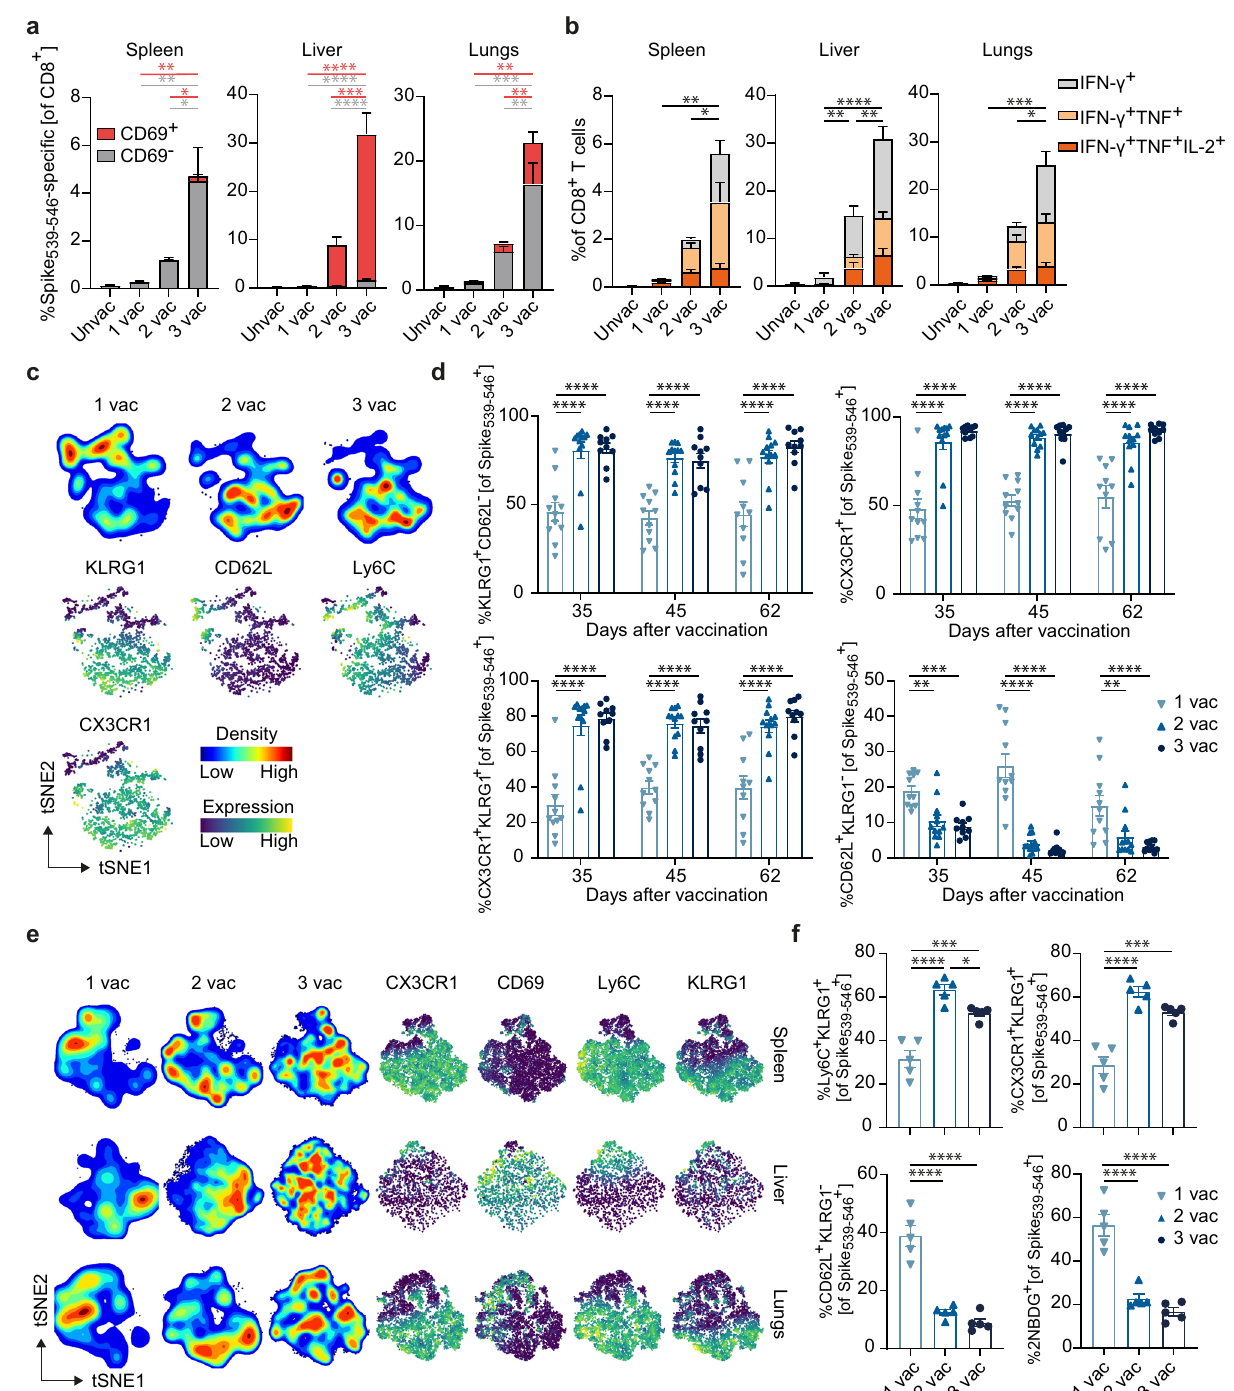
A third vaccination with a single T cell epitope augments effector-memory and tissue-resident memory CD8 + T cell formation . Next, we aimed to determine the impact and under- lying mechanisms of sequential SLP vaccinations on the memory differentiation of the elicited antigen-speci fi c CD8 + T cells. Three times vaccinated mice had 4-fold higher frequencies of circulating (CD69 - ) Spike 539-546 -speci fi c CD8 + T cells in the spleen com- pared to two times vaccinated mice, and 16-fold higher fre- quencies compared to once vaccinated mice (Fig. 3a). In the liver, the 3 rd vaccination resulted in a notably higher Spike 539-546 -spe- ci fi c CD8 + T cell response compared to the single (120-fold NATURE COMMUNICATIONS| (2022) 13:3966